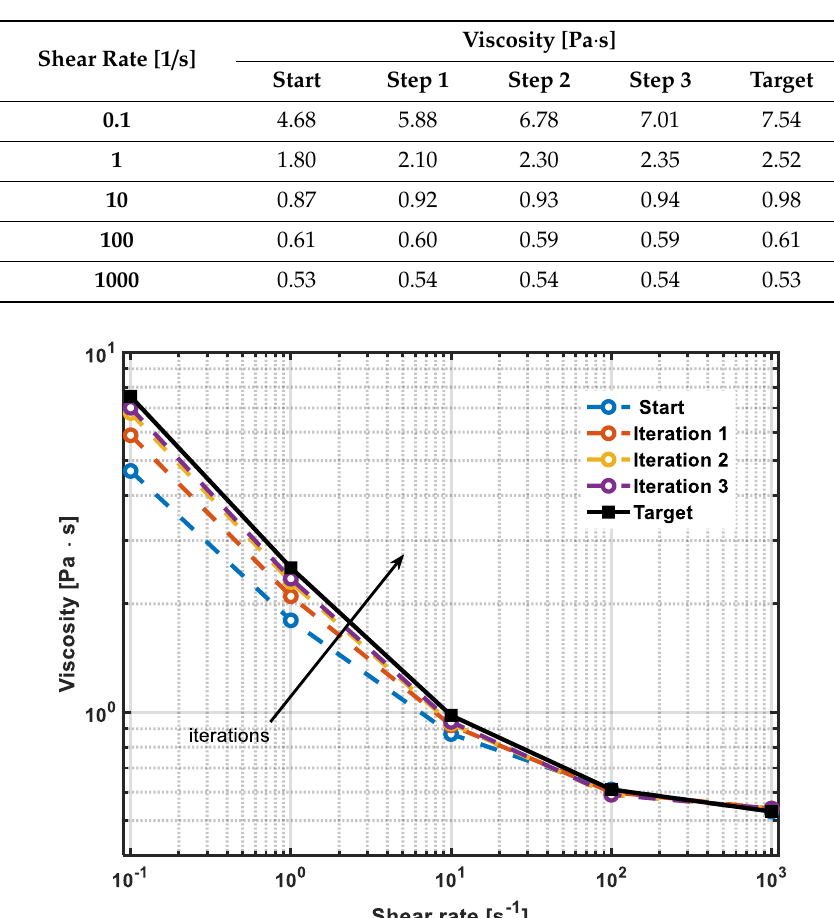
Figure 10. Rheological curves experimentally obtained during the iterations of the control action performed by the decision support algorithm. Measurements are carried out using the rheometer AR-2000 TA stress-controlled equipped with a 45 mm plate-plate fixture.